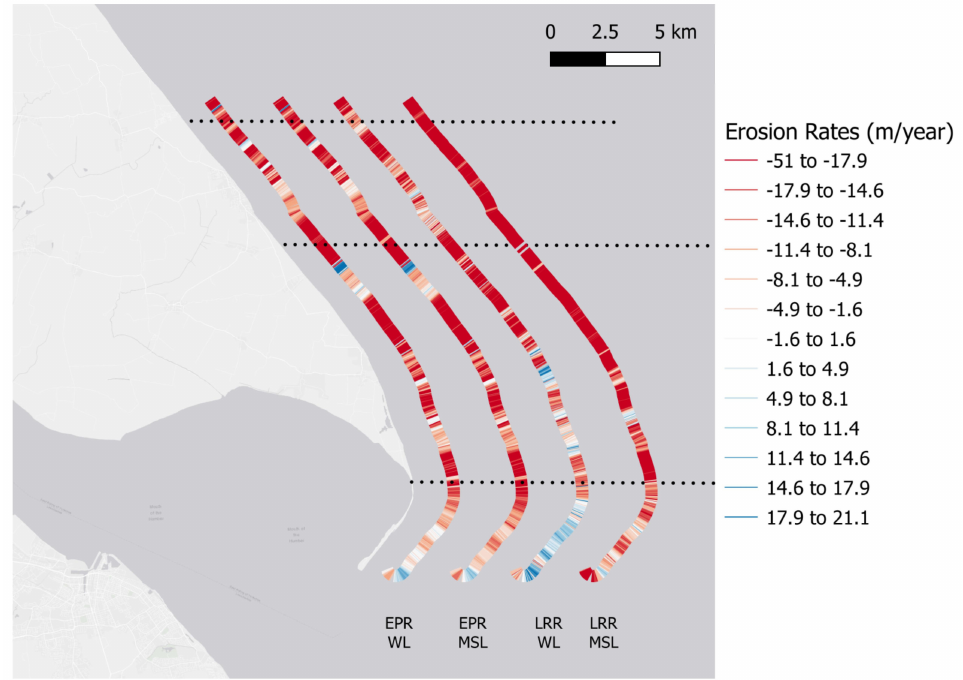
Figure 15. Coastline change rate EPR and LRR values obtained at Spurn Head (Site #1) using MSI-WL and SL-MSL between 2016 and 2019. The color bar represents change rate intensity in m/year ranging from red (erosion) to blue (accretion), with no detectable change represented in white. Source of Light Gray Canvas Base map: Esri, HERE, Garmin, © OpenStreetMap contributors, and the GIS user